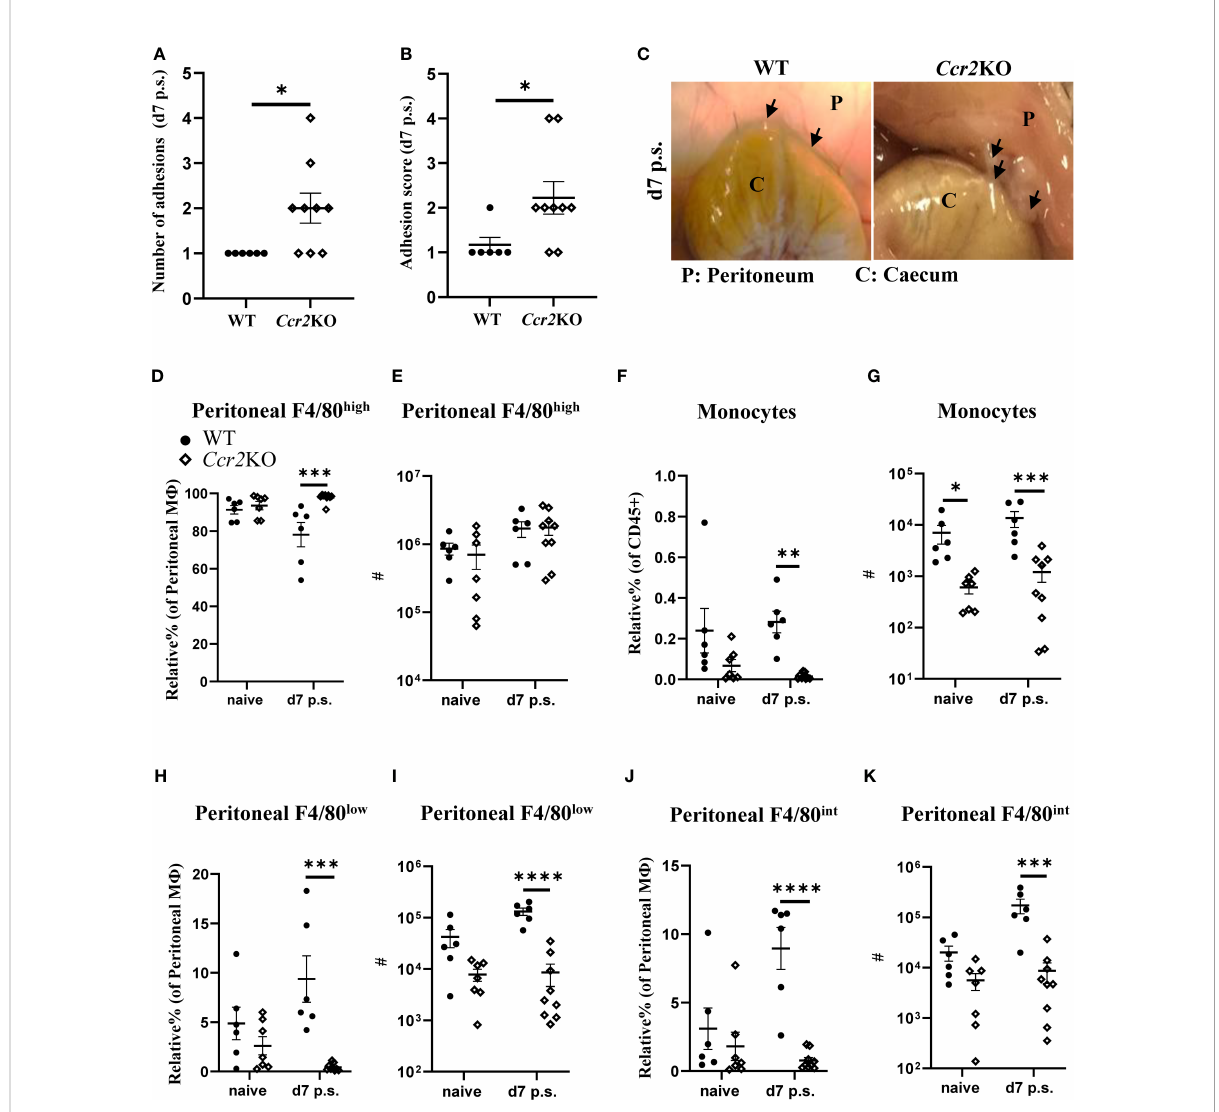
FIGURE 3 Ccr2- de fi cient mice were more susceptible to peritoneal adhesion formation post-surgery compared with their WT littermates. Number of adhesions (A) , adhesion scores (B) and representative adhesion image at day 7 after surgery (C) . Relative percentage and total cell number of peritoneal F4/80 high resident macrophages ( D, E , respectively), monocytes ( F, G , respectively), peritoneal F4/80 low monocyte-derived macrophages ( H, I , respectively), and peritoneal F4/80 int macrophages ( J, K , respectively). Data shows mean ± SEM, pooled from 5 separate experiments for naïve or 4 separate experiments for day 7, n= 6-9 mice/group; mixed male and female; * P <0.05, *** P <0.001, **** P <0.0001; (A, B) Mann Whitney test, (D – K) ANOVA with Tukey ’ s multiple comparison